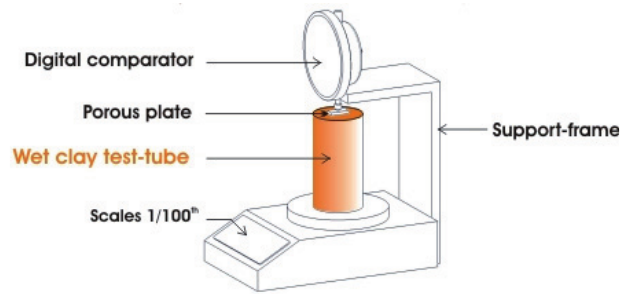
Fig. 3. Device for measuring the test-tube shrinkage and wa- ter content variation during